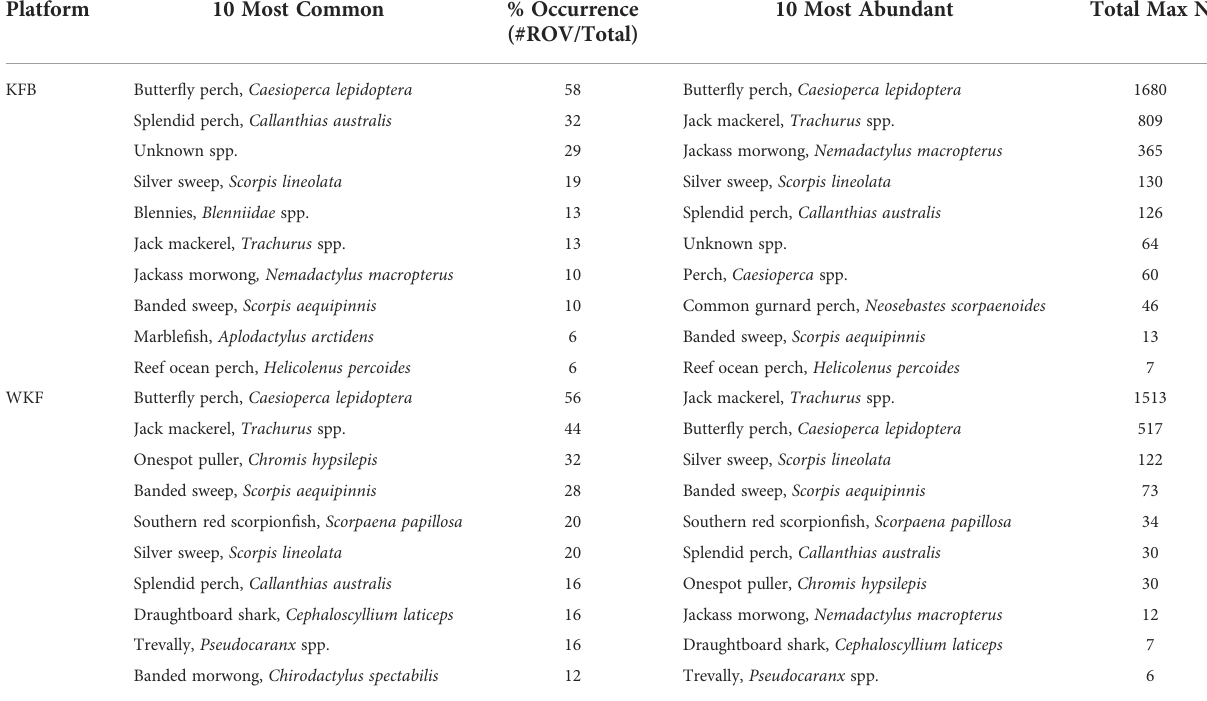
TABLE 1 Summary of the ten most common (% of occurrence: #ROV videos/total ROV videos sampled), and the ten most abundant (Total MaxN) fi sh species present at the King fi sh B (KFB) and West King fi sh (WKF) steel jacket oil and gas platforms.